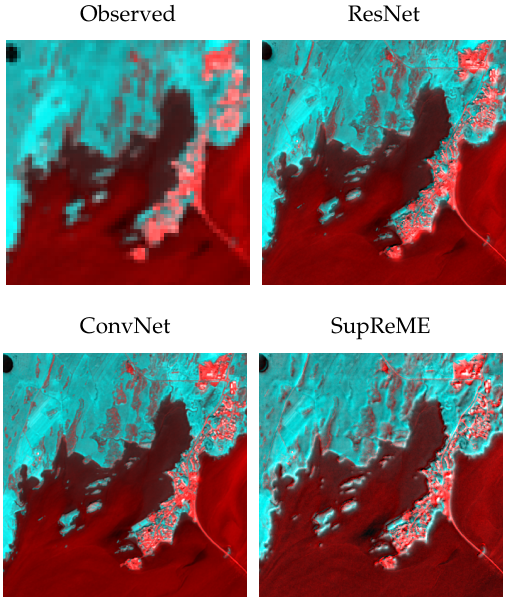
Figure 16. Full-scale (10 m) fusion results of 60 m bands rendered in false color for all methods. The subset shows the town of Borgarnes in Borgarfjörður in western